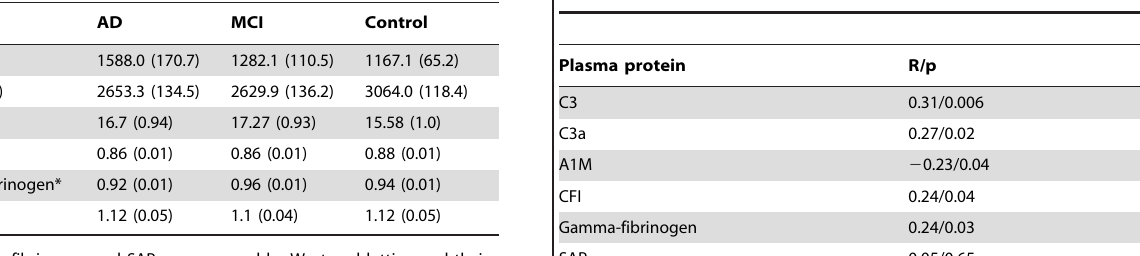
Table 3. Univariate associations between plasma concentrations of assayed candidate biomarkers and whole brain volume in AD; R=Pearson correlation coefficient; p =2- tailed statistical